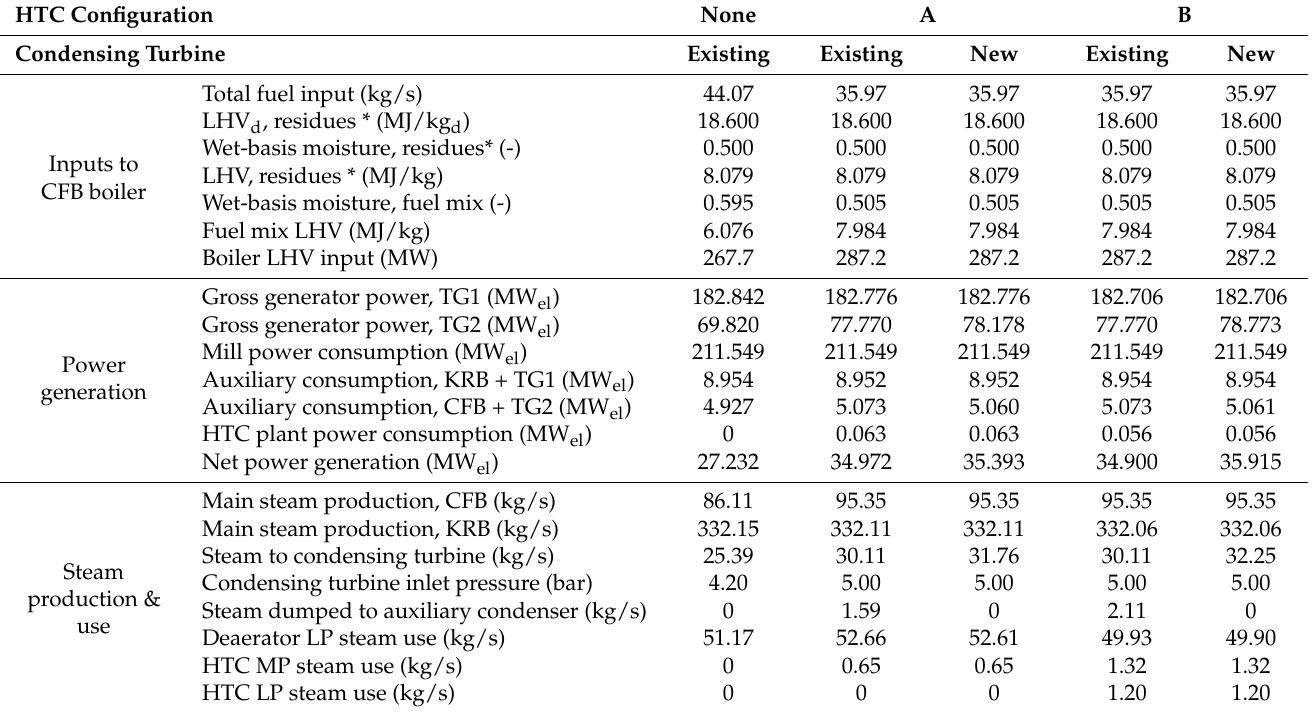
Table 5. Plant performances with different NorInt cases